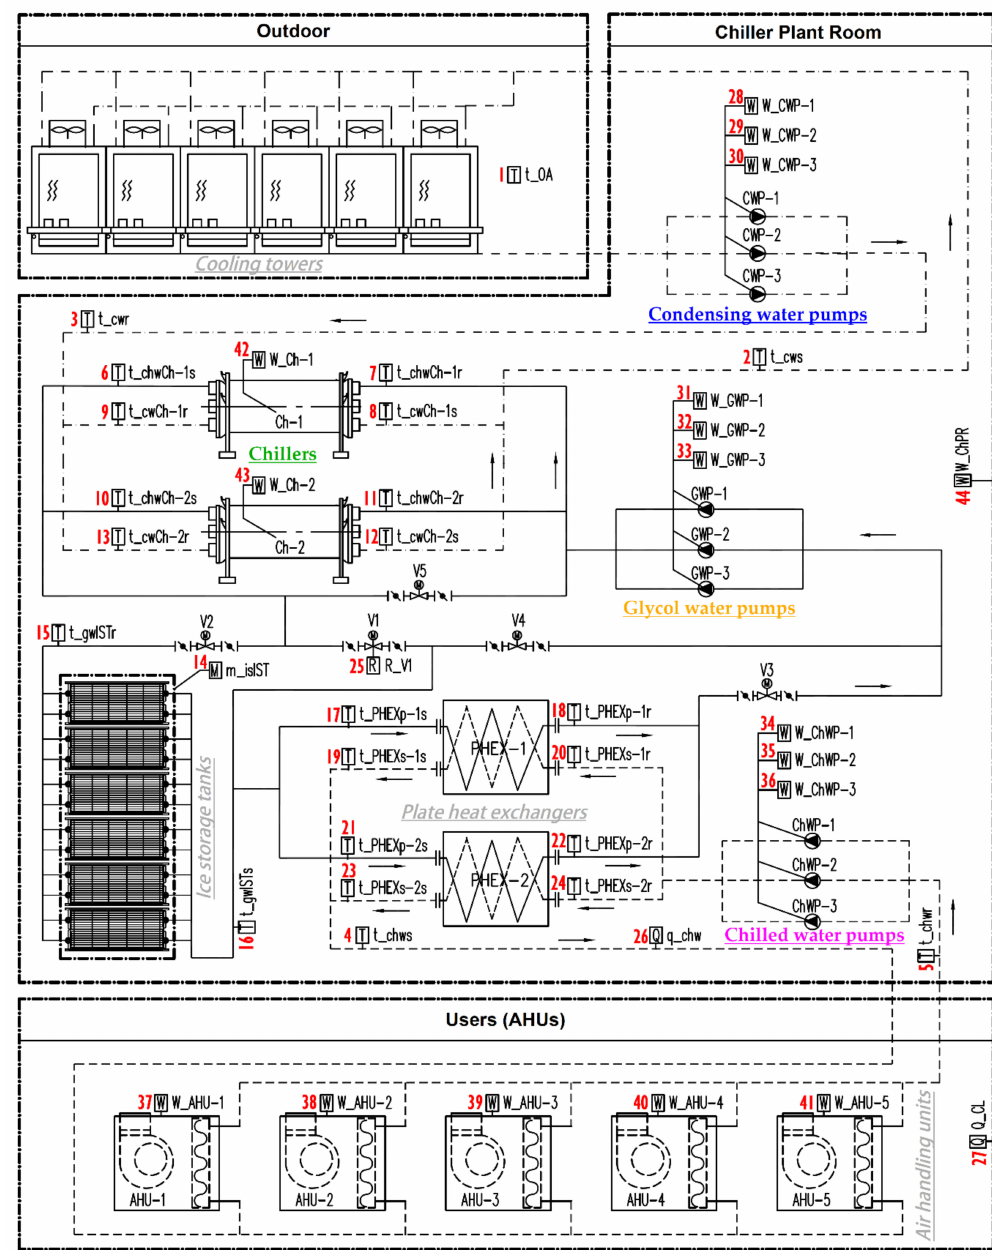
Figure 1. Scheme of the studied air-conditioning system with the monitoring locations of the operation status. The system had four operating modes, excluding the shutdown mode. Each mode was controlled based on the logic detailed in Table 1 for on/off control or the modulation of the chiller(s) and five valves (V1 to